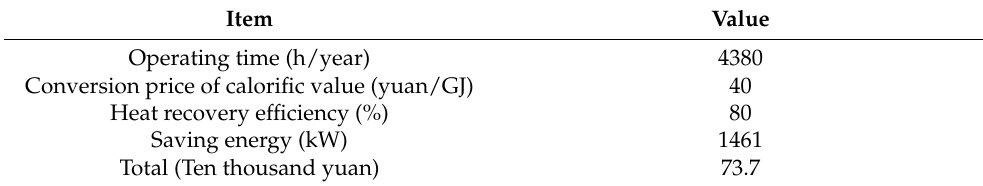
Table 5. The benefit parameters of flue gas desulfurization-waste heat recovery